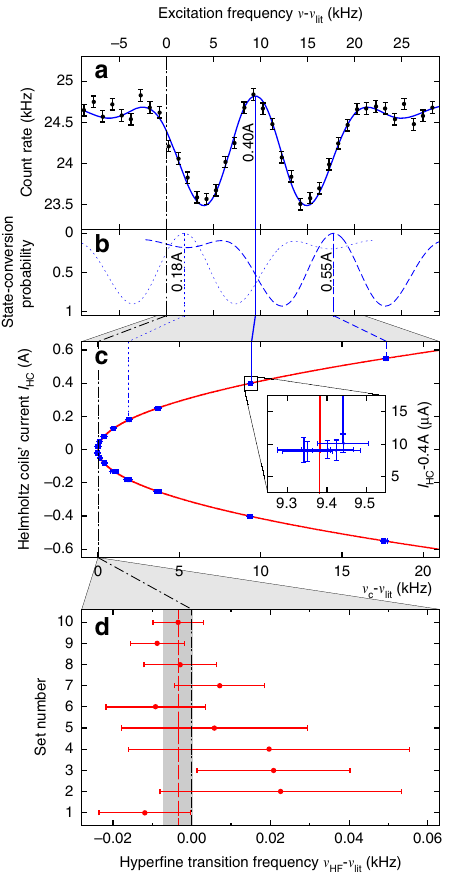
Figure 3 | Resonance spectrum and zero-field value extraction. ( a ) Data with Poisson errors of one cycle of set 8 at a Helmholtz coils’ current I HC ¼ 400mA fitted with the resonance curve ( F R , full blue line, see equation (13) in Methods) to extract the central frequency n c , which is Zeeman-shifted to values 4 n HF . A dashed-dotted black line at 0 is drawn through all the plots to represent n lit . ( b ) State-conversion probabilities Fð Þ as obtained from the fit F R ð Þ of two other cycles of the same set, but at different settings of I HC (dotted blue line 180mA, dashed blue line 550mA, data omitted for clarity). ( c ) n c of all 80 cycles of set 8 (16 different values of I HC , 5 cycles each) plotted against I HC for extraction of the zero-field hyperfine splitting n HF using the Breit–Rabi fit function n 0 (red line) of s equation (4). The inset is a zoom into the group of five cycles at I HC ¼ 400mA, illustrating the typical size of the frequency and current s.d. of each data point. ( d ) The resulting n HF as deviation from n lit for the 10 sets (red s.d. error bars) and their weighted mean value (dashed red line) with the 1 s.d. total uncertainty as grey-shaded